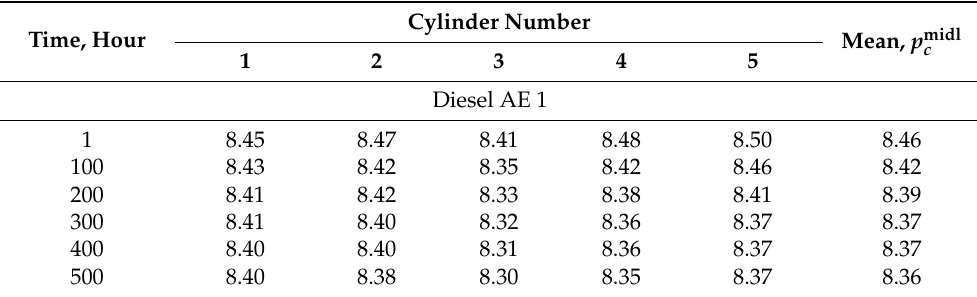
Table 5. Compression pressure change, MPa, diesel engine 5L23/30 MAN-B&W Diesel Group under different experimental